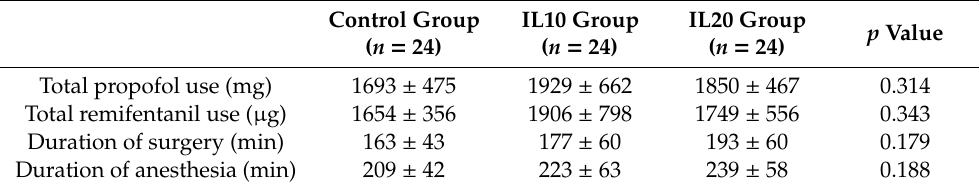
Table 2. Intraoperative